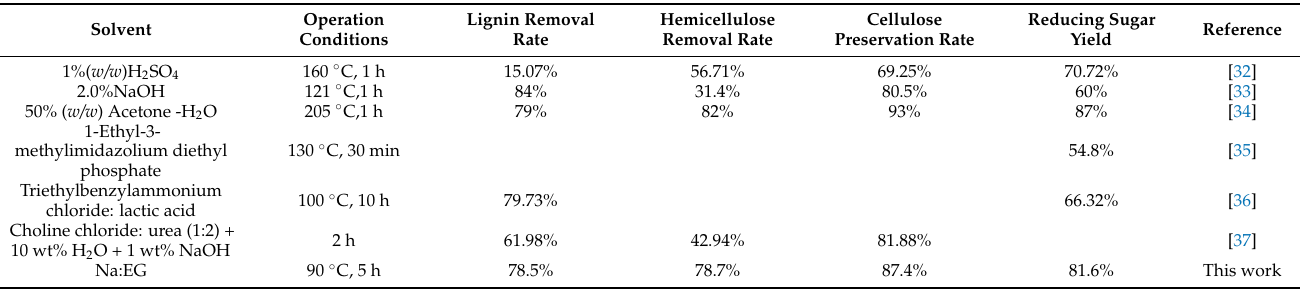
Table 3. The comparison of different chemical methods.